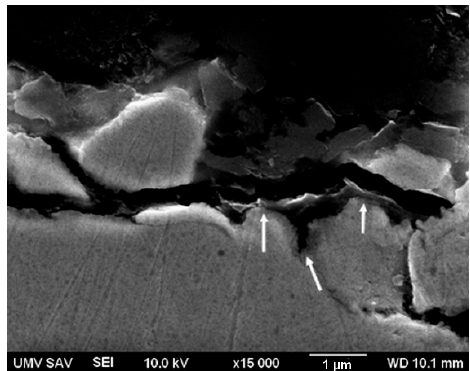
Figure 3. Representative cross-sectional micrograph of the polymer coating layer on the surface of Fe-PEG3 sample containing, 3.0 wt. % PEG (white arrows point to the interface).